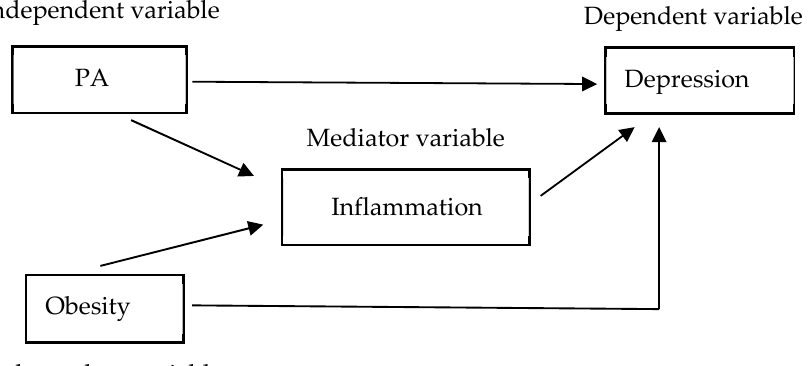
Figure 1. Theoretical model of the present study, based on Baron and Kenny’s four-step approach. Effect of PA and obesity on depression, with inflammation potentially acting as a mediator. There are four criteria required to conclude mediation: (1) the independent variable (PA or obesity) should significantly predict the dependent variable (depression); (2) the independent variable (PA or obesity) should significantly predict the mediating variable (inflammation); (3) the mediating variable (in- flammation) should significantly predict the dependent variable (depression); and (4) after adjusting for the mediating variable (inflammation), the association between the independent variable (PA or obesity) and the dependent variable (depression) should be reduced (partial mediation) or should be no longer significant (complete